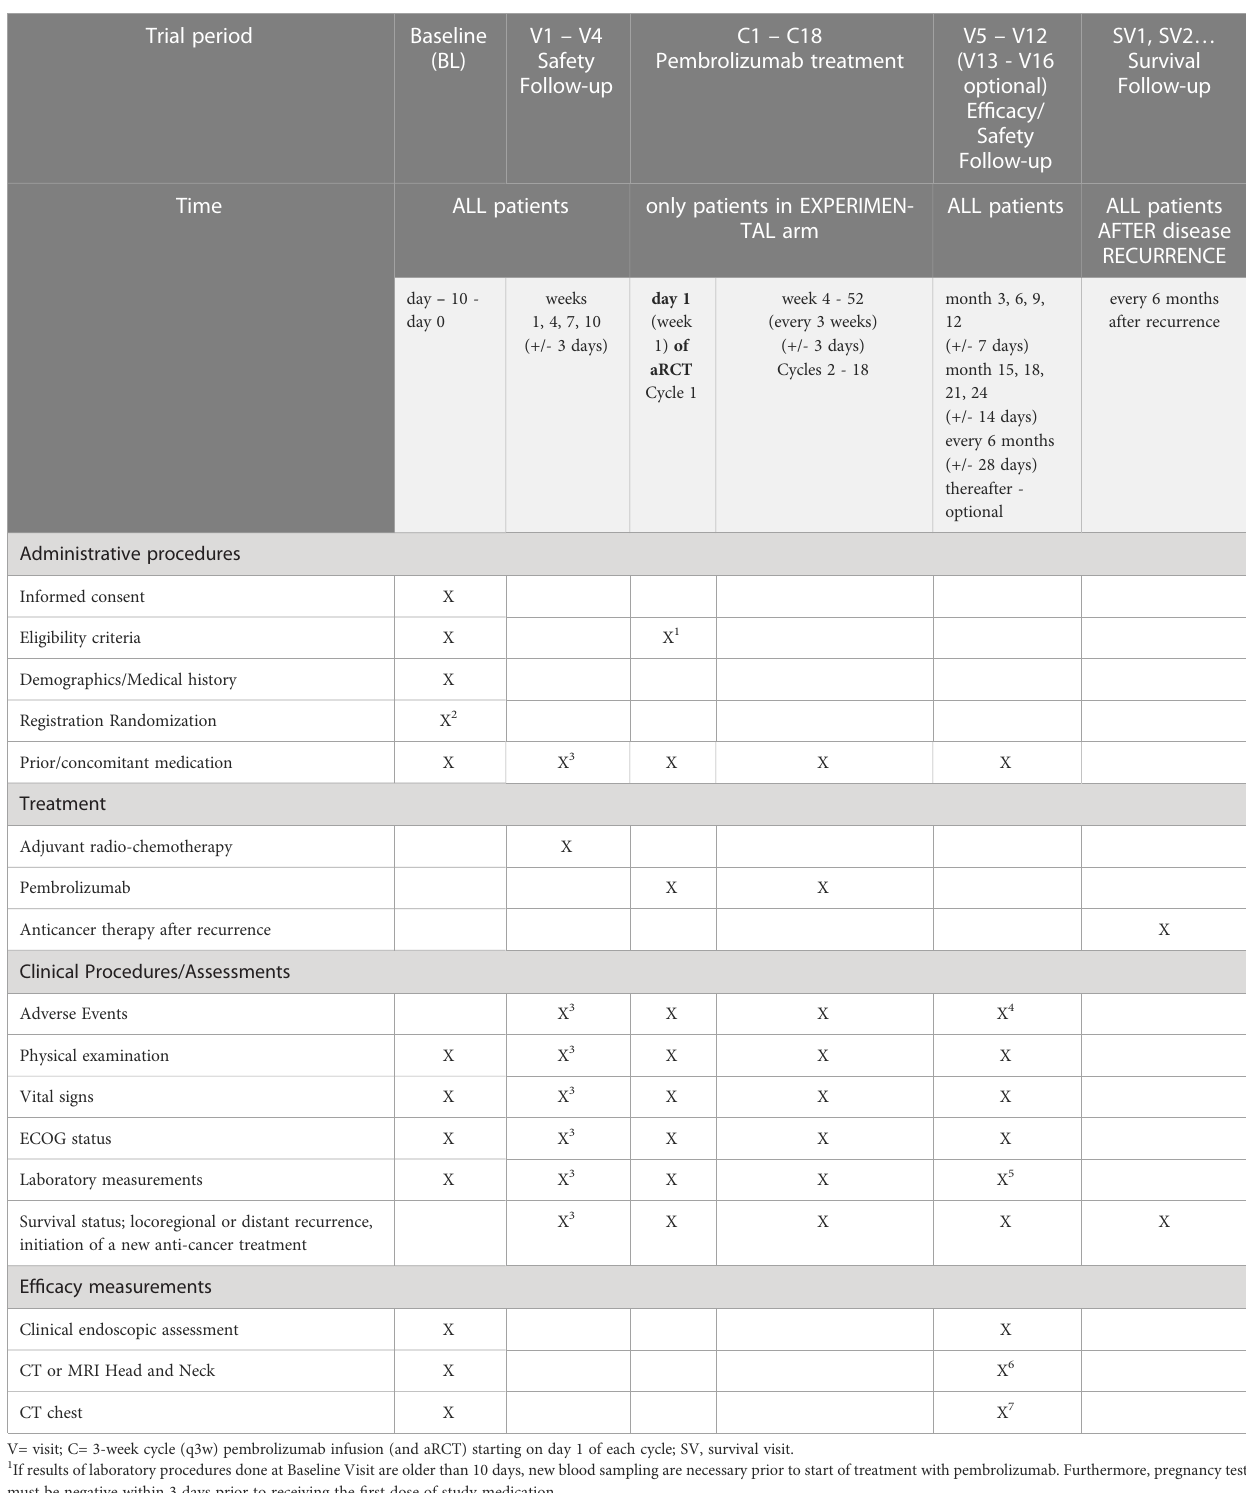
TABLE 4 Schedule of trial